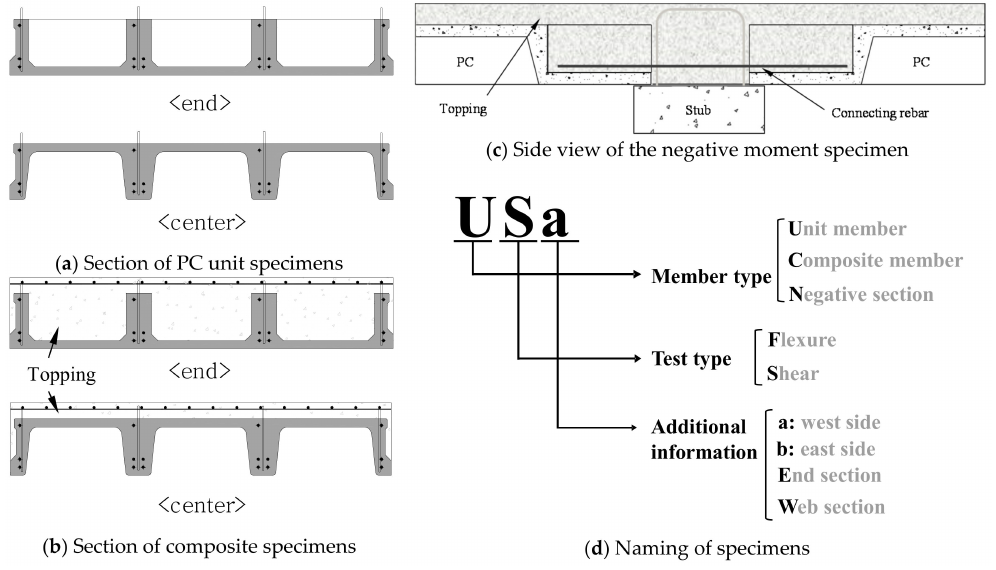
Figure 4. Summary of the test